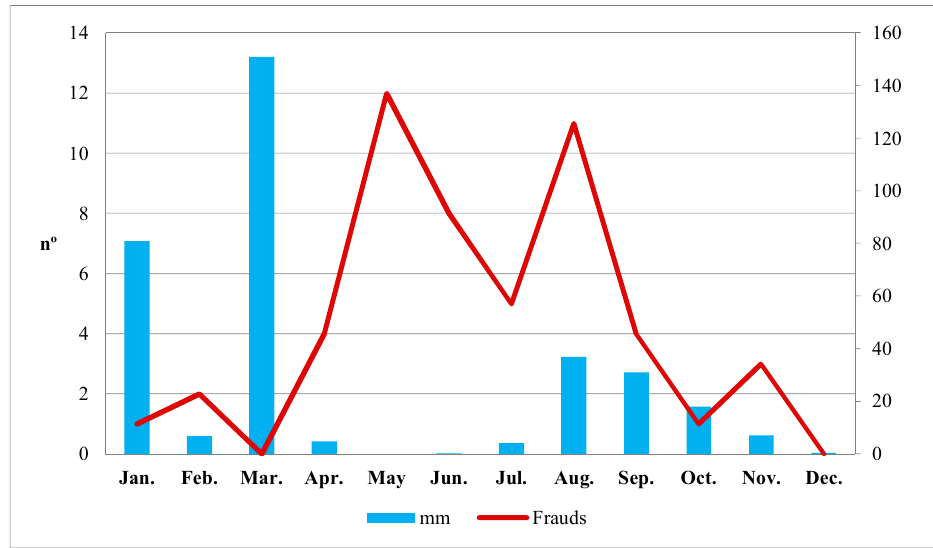
Figure 8. Evolution of unauthorised domestic water consumption detected in the low density urban model and monthly precipitations in the city of Alicante (2017). Source: AMAEM; AEMET (2017). Own elaboration.